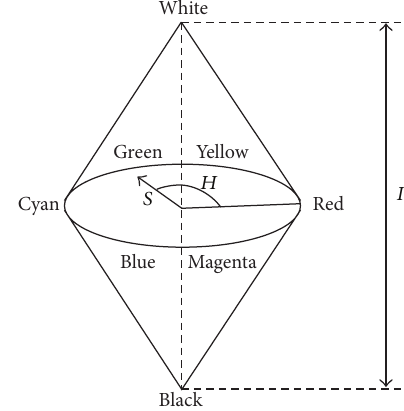
Figure 1: RGB color model.